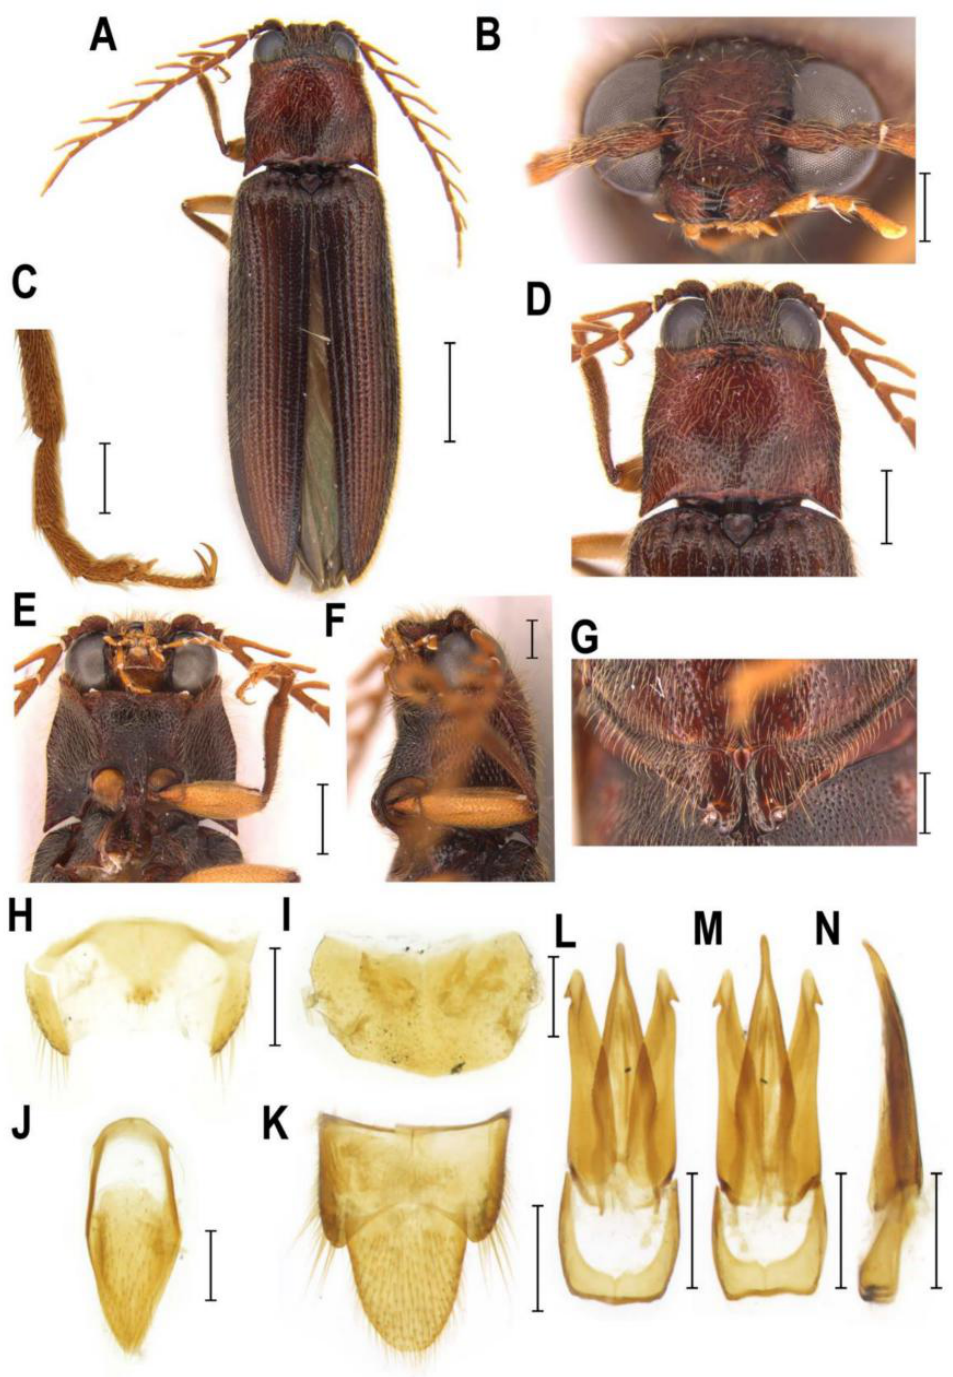
Figure 6. Morphology of Austrelater sp., Australia, male. ( A ) habitus, dorsal view; ( B ) head, frontal view; ( C ) right metatibia and metatarsus; ( D ) pronotum, dorsal view; ( E ) prosternum, ventral view; ( F ) prosternum, lateral view; ( G ) metacoxal plate; ( H ) abdominal sternite VIII; ( I ) abdominal tergite VIII; ( J ) abdominal sternite IX; ( K ) abdominal tergites IX–X; ( L ) aedeagus, dorsal view; ( M ) aedeagus, ventral view; ( N ) aedeagus, lateral view. Scale bars = ( A ): 2 mm; ( D – E ): 1 mm; ( B – C , F – N ): 0.5